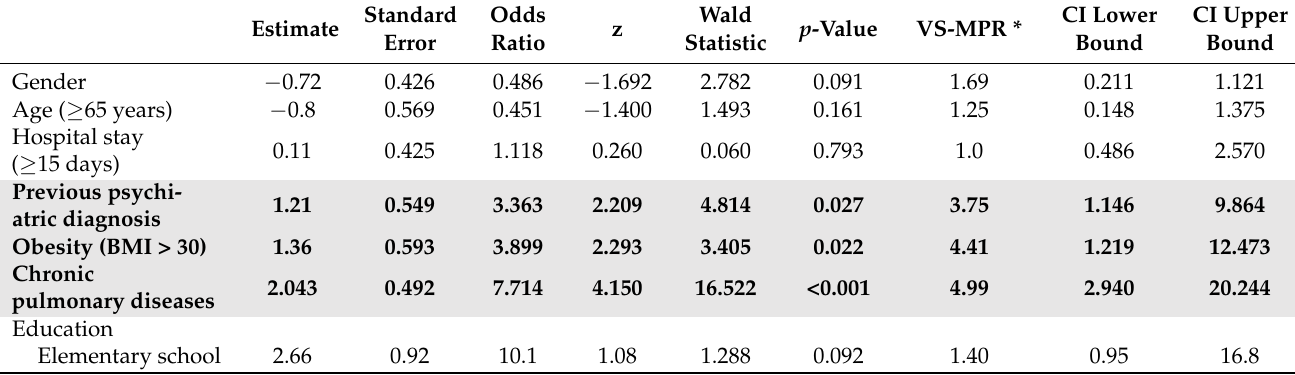
Figure 2. PCL-5 total score trajectories in patients with PTSD and the total amount of patients with PTSD at different follow-up assessments. Table 3. Multivariate logistic model predicting chronic